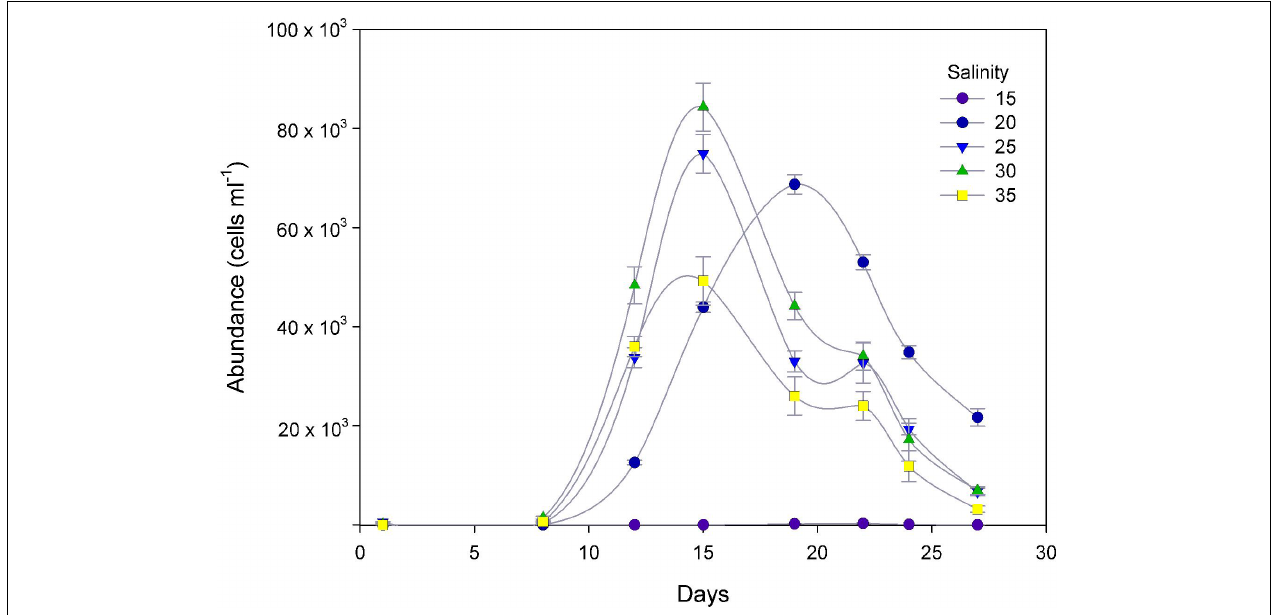
FIGURE 4 | Temporal cell growth curves of P. verruculosa cultures under five salinity treatments. Symbols represent the mean and error bars the standard deviation of cell counts from triplicate measurements.